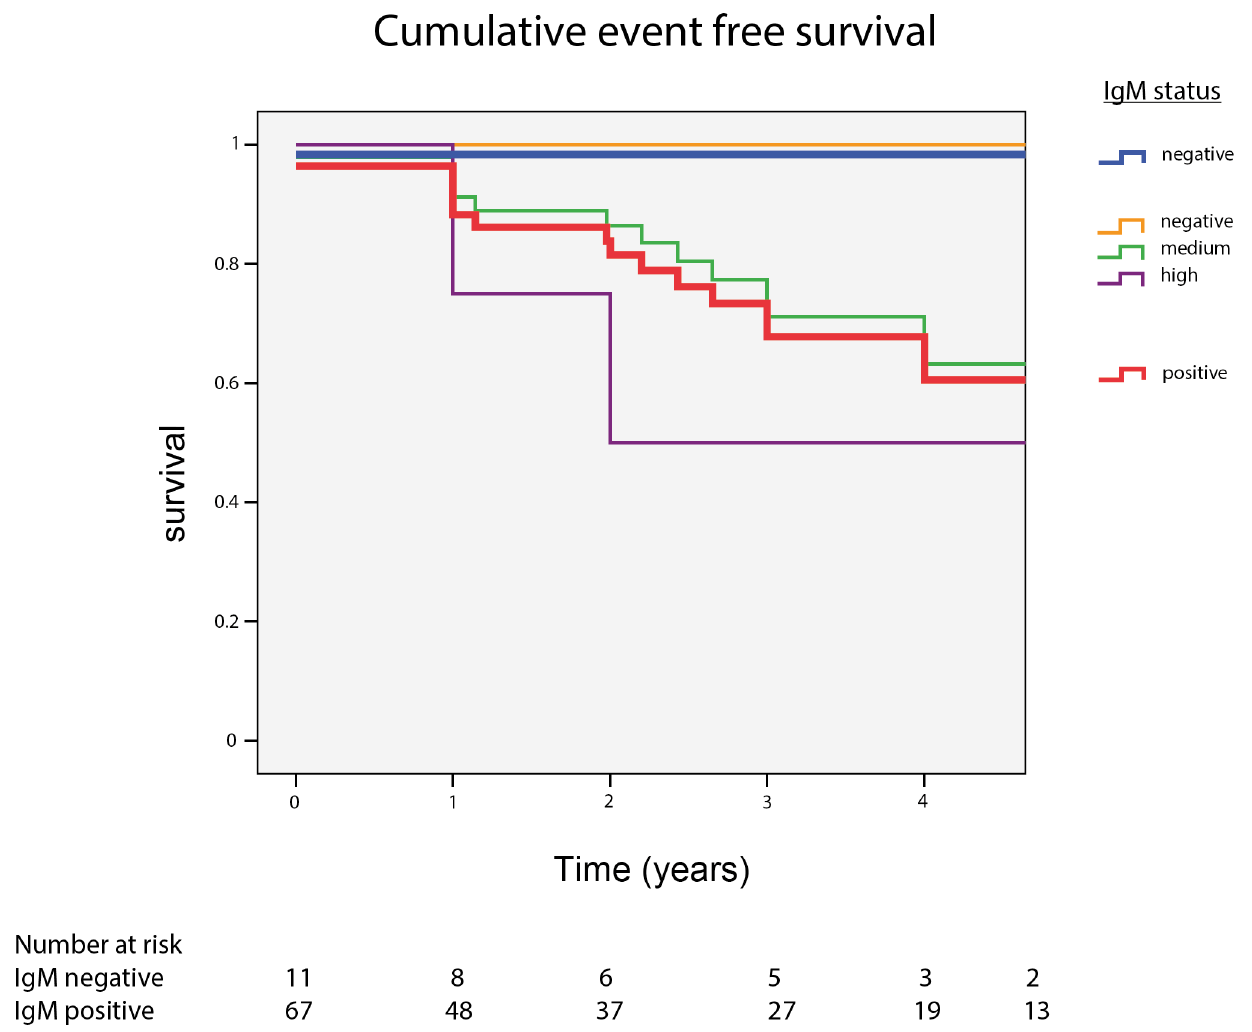
Figure 9. Cumulative event free survival of patients with anti-HDV IgM positive and negative values.